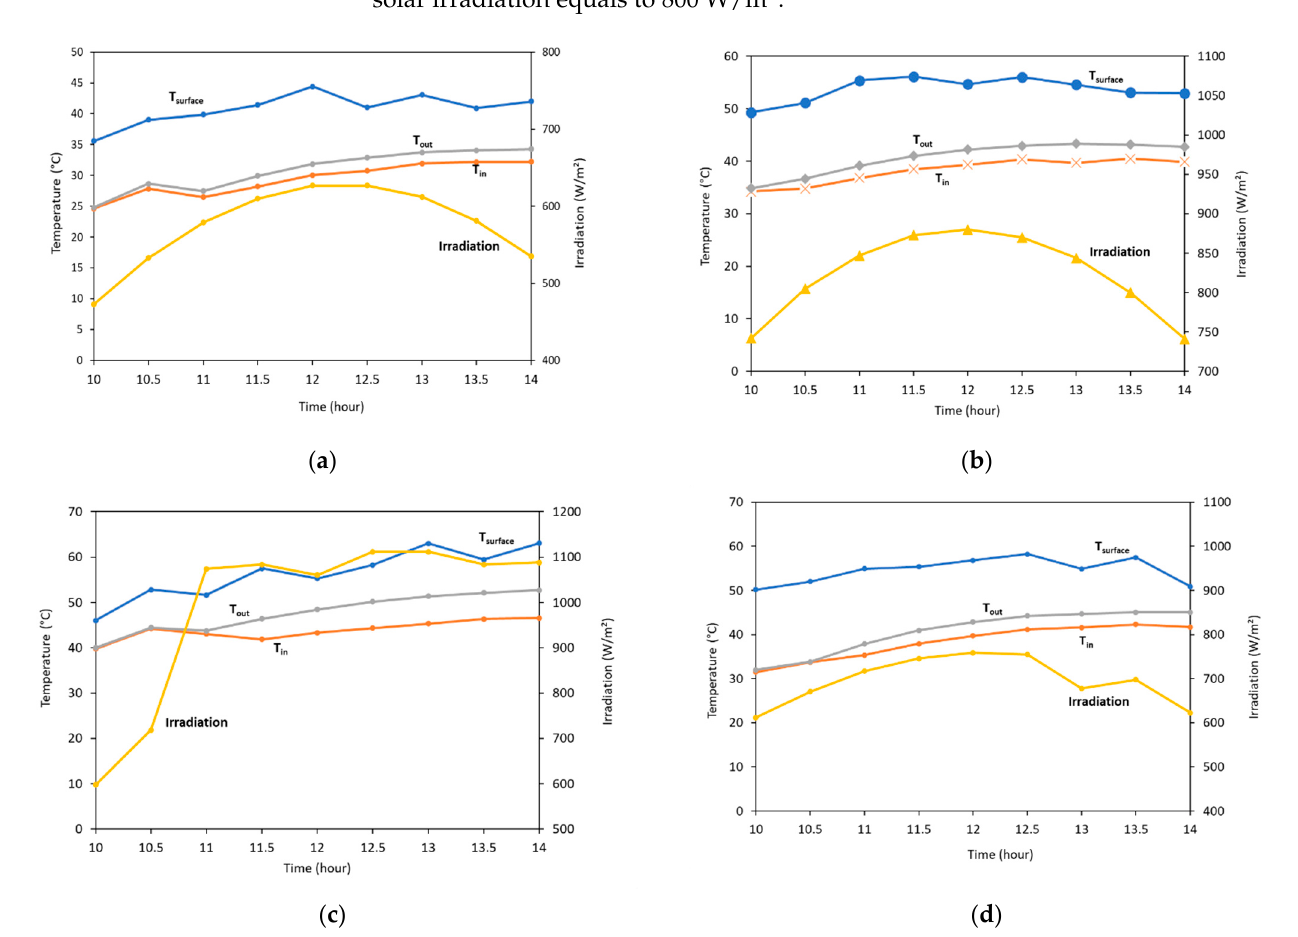
Figure 4. PVT test results: ( a ) winter day, ( b ) spring day, ( c ) summer day, ( d ) autumn day.